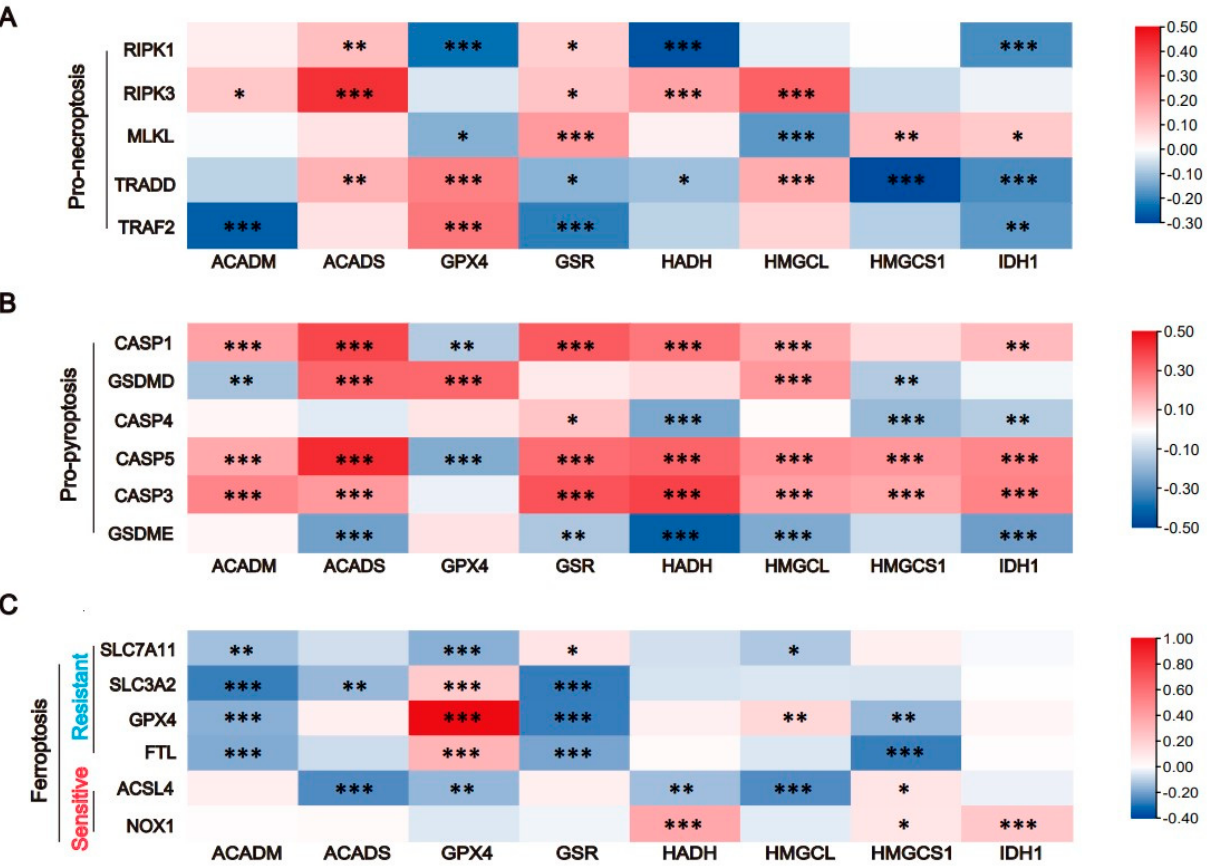
Figure 4. The expression of key enzymes is closely related to cell death. ( A ). The correlation of these eight genes with cellular necroptosis. ( B ). The correlation of these eight genes with cellular pyroptosis. ( C ). The correlation of these eight genes with cellular ferroptosis. (“ * ” represents p < 0.05, “ ** ” represents p < 0.01, “ *** ” represents p<0.001 )